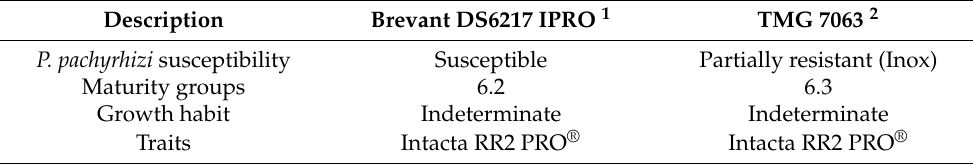
Table 2. Description of the cultivars that were adopted in the experimental